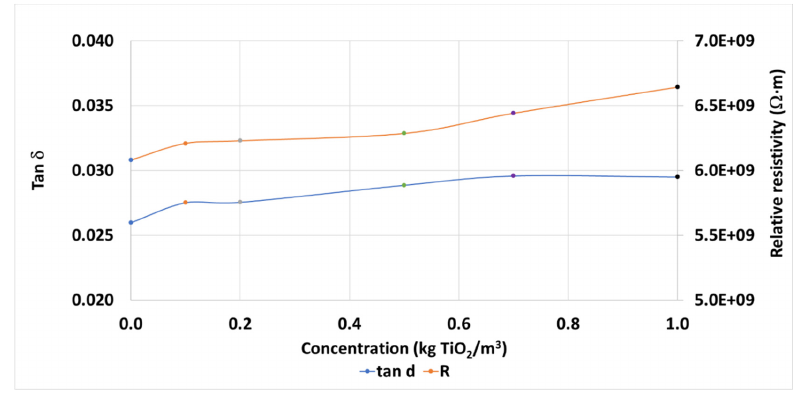
Figure 5. Mean moisture content of tested TiO 2 nanofluid samples.